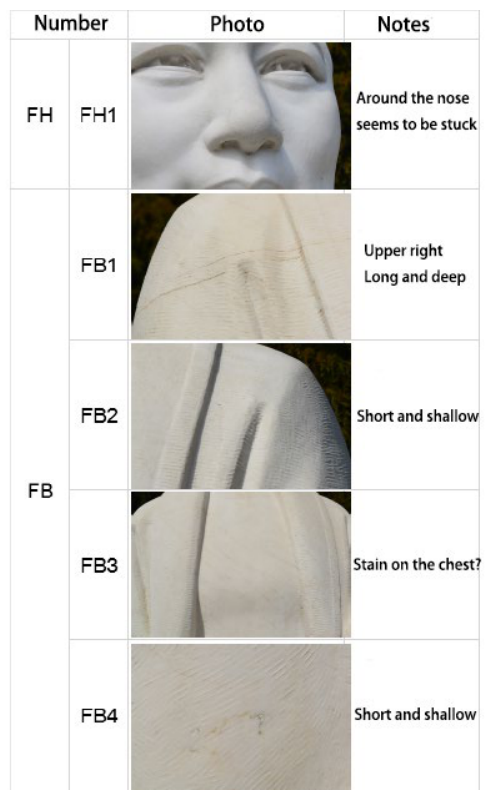
Figure 7 . Detailed recordings of every visible crack including its number, a close-range photo and description. (Source: Yijie Wang, Tianyue